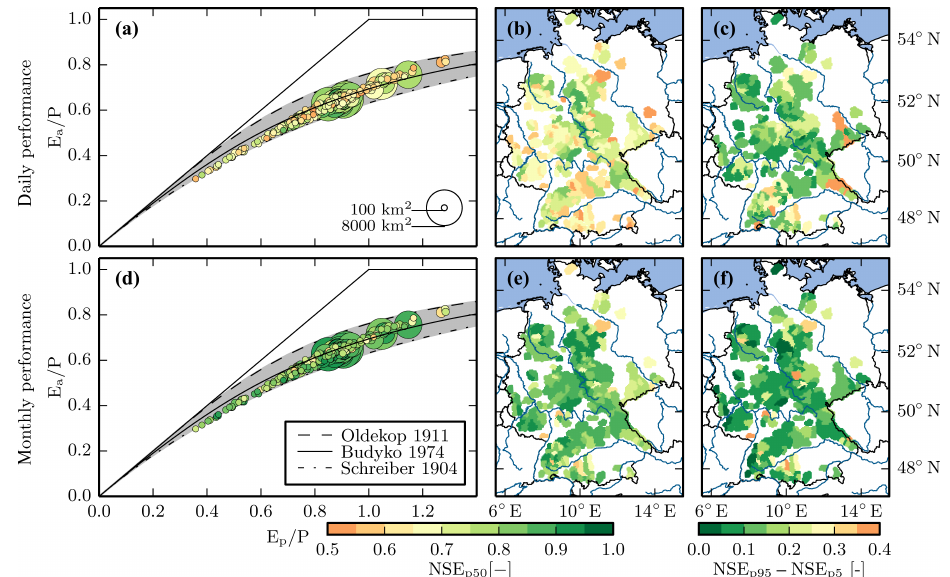
Figure 4. Budyko plot and performance maps for 100 ensemble parameter sets at 222 basins spread over Germany. The upper row depicts evaluations based on daily values (a, b, c) , whereas the lower row depicts monthly streamflow evaluations (d, e, f) . In the first column the basins are presented as Budyko plots (a, d) , which are color-coded based on the ensemble median NSE for daily (a) and monthly (d) streamflow values. The gray band envelops different estimations of the Budyko curve (Schreiber, 1904; Ol’dekop, 1911; Budyko, 1974). A separation to energy- ( E p /P < 1) and water-limited basins ( E p /P > 1) can be made based on the x axis. The center column depicts the location of the 222 basins shown in the Bydyko plots using the same color code (b, e) . The right column shows the range of the 5th and 95th ensemble percentiles for the NSE on daily (c) and monthly (f) basis. (a) , (b) , (d) , and (e) share the left color bar, and (c) and (f) share the right color bar. The simulation period is adopted according to the available streamflow observations but is at least 10 years (average = 42